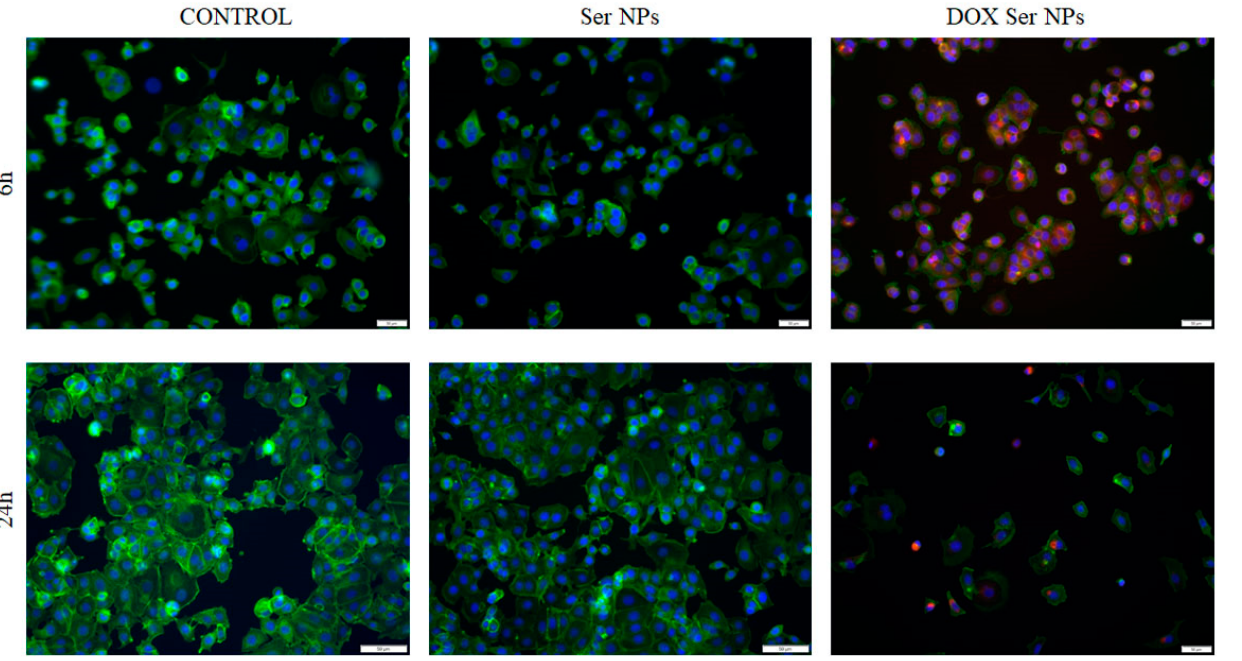
Figure 11. Fluorescence microscopy images of MCF-7 cells treated for 6 h and 24 h with free Ser NPs and DOX-loaded Ser NPs, as compared with an untreated MCF-7 monolayer: green fluorescence–phalloidin–FITC: actin filaments; blue fluorescence–DAPI: cell nuclei; red fluorescence–DOX). Scale bar: 50 µm.